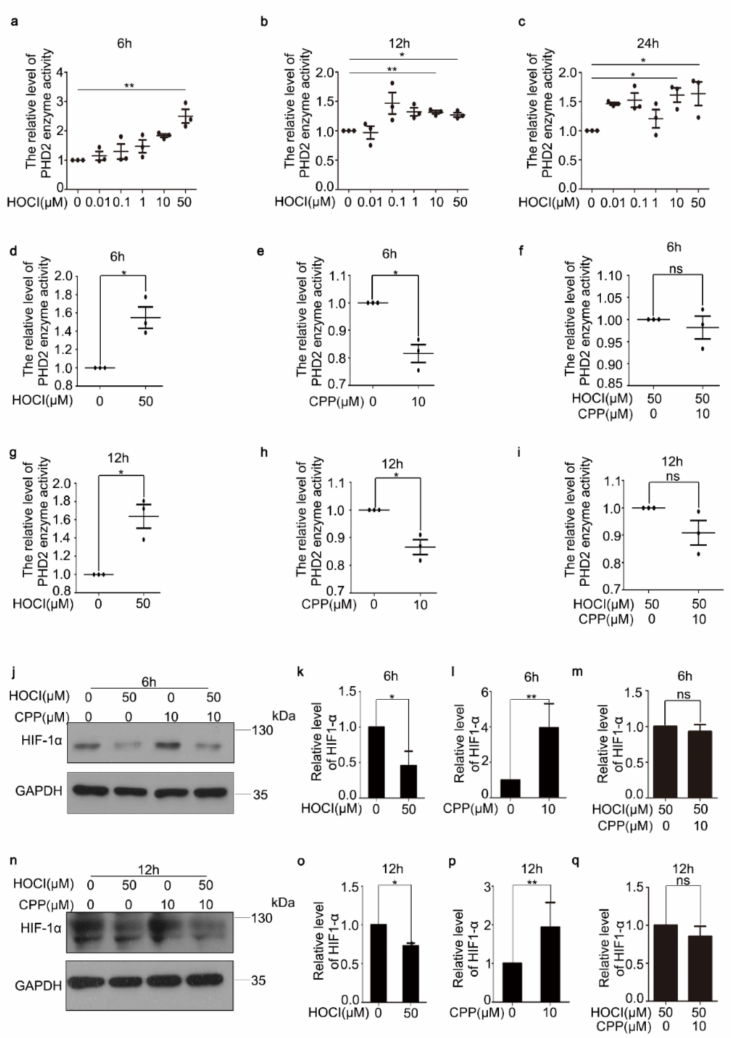
Figure 4. Exogenous hypochlorous acid partially reversed the CPP-inhibited activity of PHD2 and the CPP-increased protein level of HIF1a. ( a – c ) HOCl activates PHD2. PHD2 activity was examined using a PHD2 enzyme-linked immunoassay kit in HDFs treated with HOCl (0, 0.01, 0.1, 1, 10 or 50 µ M) for 6, 12 or 24 h, respectively. ( d – i ) HDFs were pretreated with HOCl (50 µ M) for 6 or 12 h, and then were treated with CPP (10 µ M) for 48 h, after which PHD2 activity was examined using a PHD2 enzyme-linked immunoassay kit. ( j – q ) Protein levels of HIF-1 α were examined by Western blot. Data are presented as means ± SEM, * p < 0.05, ** p < 0.01, n =